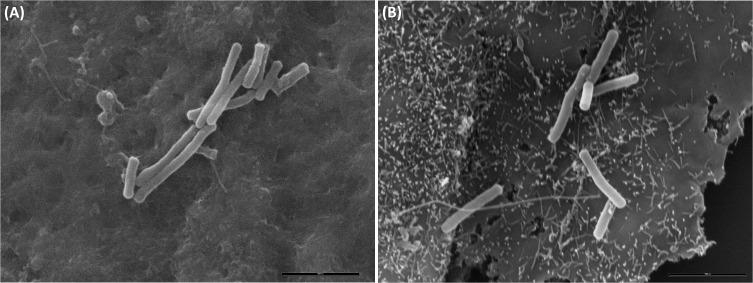
Scanning electron microscopy of C. perfringens interacting with epithelial cells.Caco-2 cells were incubated for 2 h with PBS buffer (A) or ITX (B). No superficial protrusions were observed in PBS treated cells, although bacteria were attached to the cells surface after 2 h of anaerobic incubation. ITX treatment induced the formation of membrane protrusions in Caco-2 cells and clostridia cells were adhered to these cellular deformations.